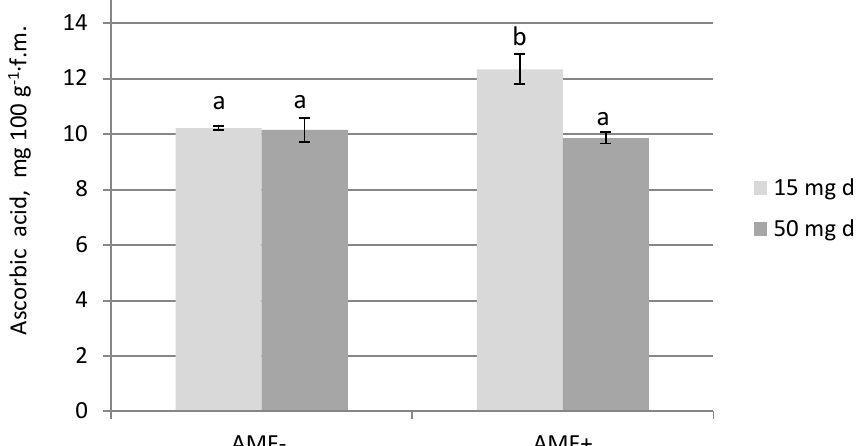
Fig. 4. Interaction between phosphorus level in nutrient solution and mycorrhiza on ascorbic acid content in tomato fruits Means followed by different letters differ at p < 0.05.; bars indicate standard error AMF-/AMF+ – non-inoculated plants by arbuscular mycorrhizal fungi (AMF)/inoculated plants by AMF f.m. – fresh